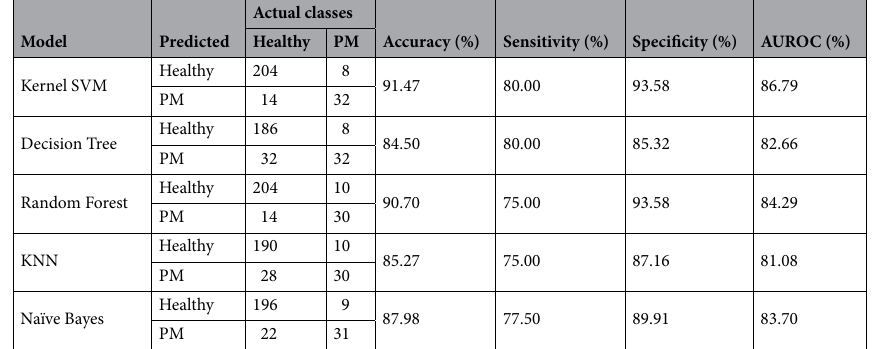
Table 4. The performance of Kernel SVM, decision tree, random forest, KNN, and Naïve Bayes using all six ocular instrumentation features. AUROC area under receiver operating characteristic curve, SVM support vector machine, PM pathologic myopia.